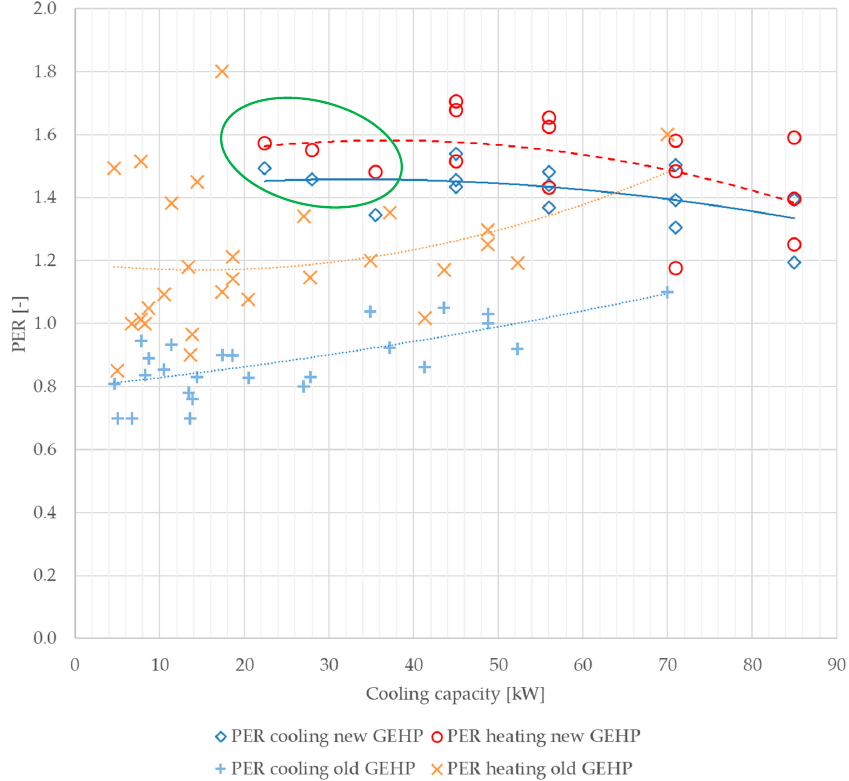
Figure 18. PER as a function of cooling capacity in heating and cooling mode for oldest and newest GEHPs. newest